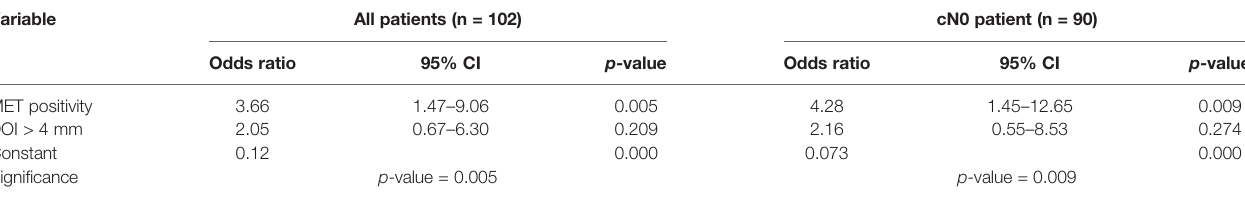
TABLE 5 | Multivariable binary logistic regression model investigating the independent effect of MET positivity and DOI > 4 mm on pN+ for all cancers (n = 102) and cN0 cancers (n = 90). Variable All patients (n = 102)